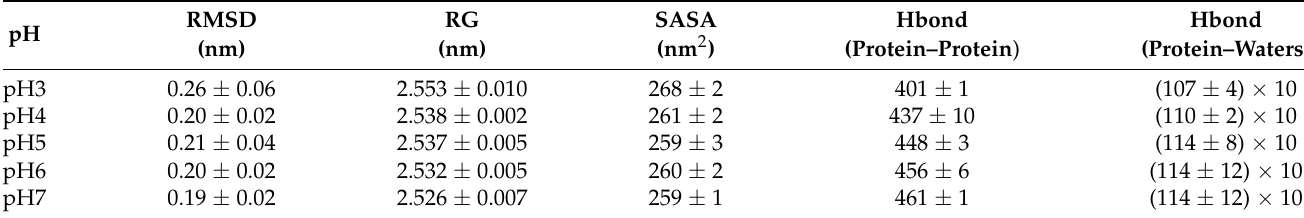
Table 2. Values of the MD were fitted against the average structure of the last 100 ns of the dynamics was used.